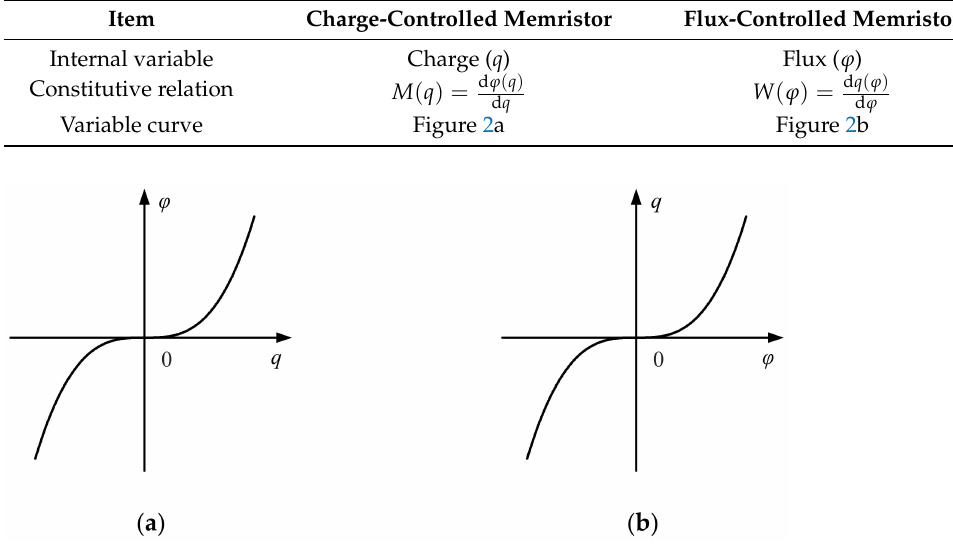
Figure 2. Characteristic curves of the memristor. ( a ) Charge-controlled memristor; ( b ) flux-controlled